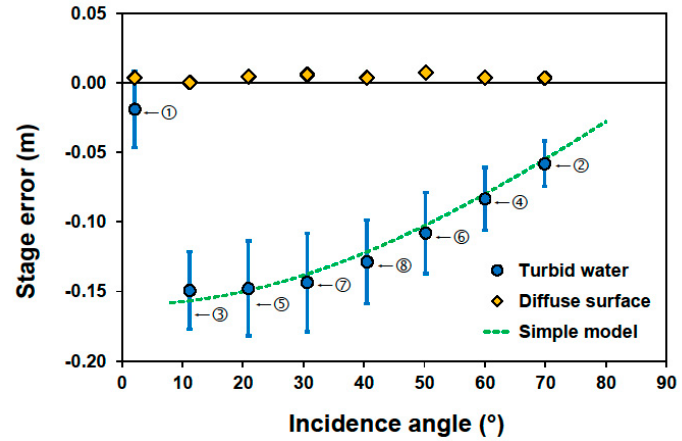
Figure 4. Laboratory test showing that an inclined Lidar does not detect the surface of turbid water but rather the suspended particles that are below: stage error (i.e., Lidar stage estimation from Equation (1) minus the reference stage value) as a function of the Lidar incidence angle when it points at a turbid water surface (each number provides the order of the measurement, each point is the mean of ≈ 30 replicates and each error bar is one-standard-deviation of the replicates) or at a thin diffuse sheet placed above the water surface (in this case, the one-standard-deviation is close to the symbol size). The simple model is represented by Equation (2) with ∆ D 0 = 0.12 m (fitted value). In this example, the Lidar was operating in the “first pulse” mode and the solid particles added to the water were an Andosol material mixed with